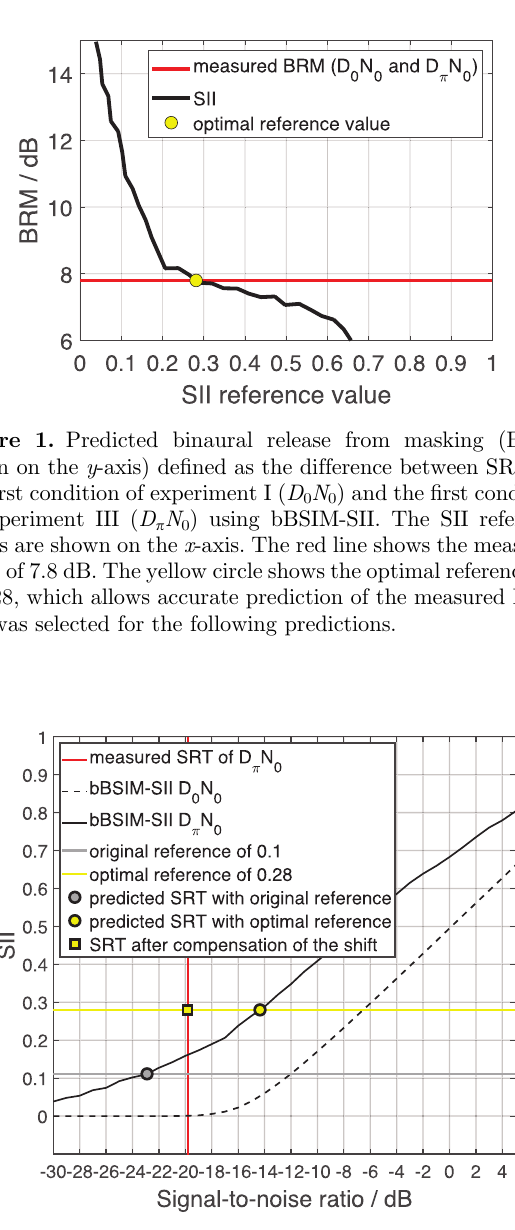
Figure 2. Illustration of the calibration of the reference SRT for accurate prediction of the BRM and example how to estimate SRT in the D p N 0 condition. See Section 2.5 for